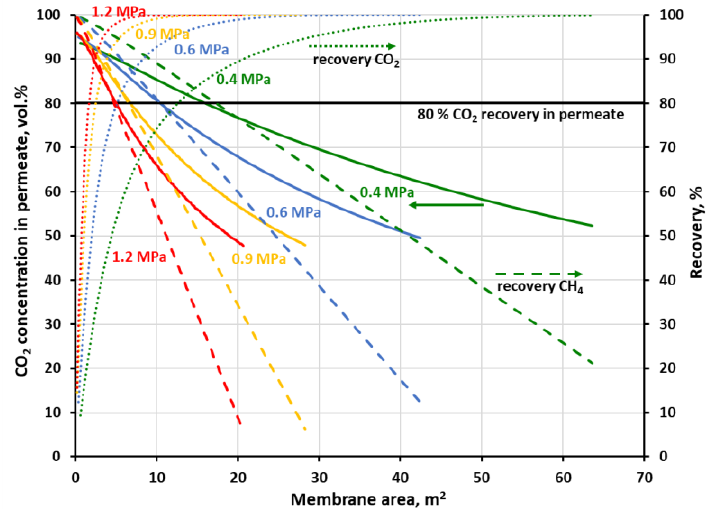
Figure 10. CO 2 concentration (solid lines) and recovery (dotted lines) in permeate along with CH 4 recovery (dashed lines) in retentate against membrane area and feed gas pressure for a one-stage biogas upgrading system with the polysulfone (PRISM PA1020) membrane.